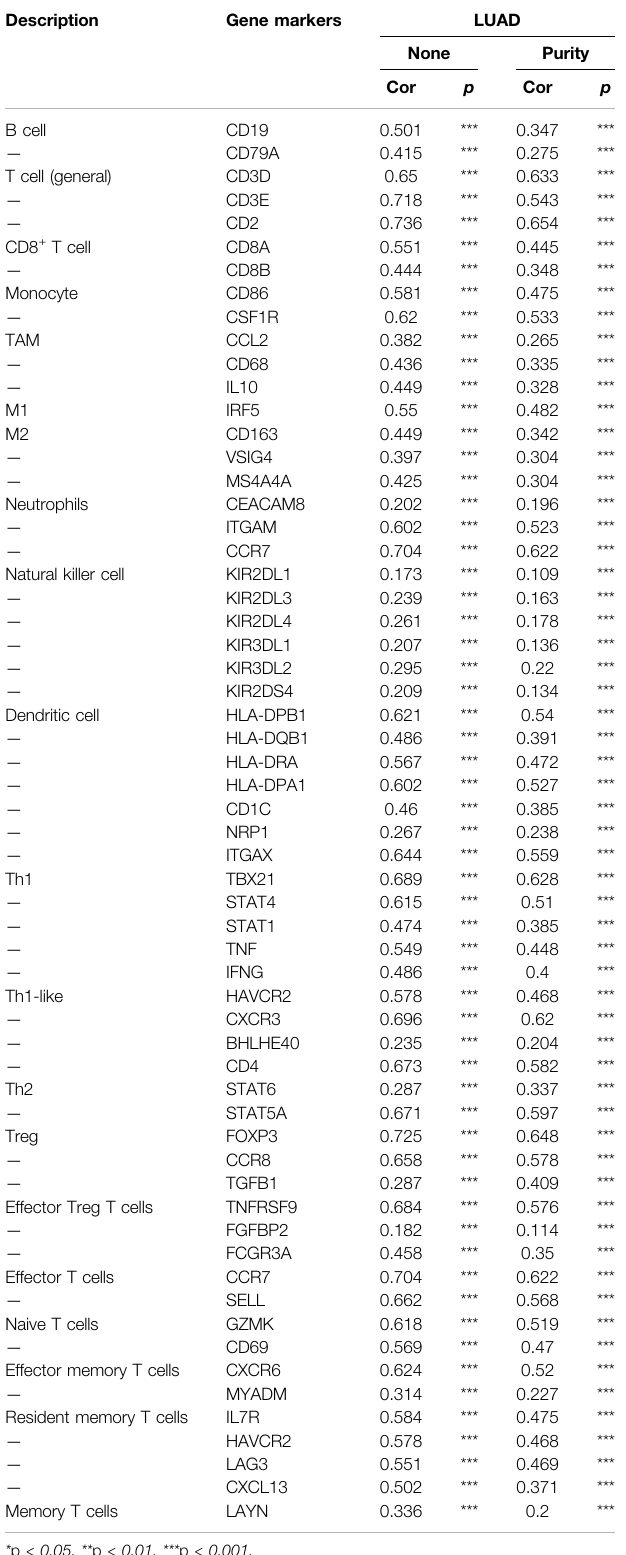
TABLE 2 | The correlation between NCAPG and gene markers of immune cells examined by TIMER database.